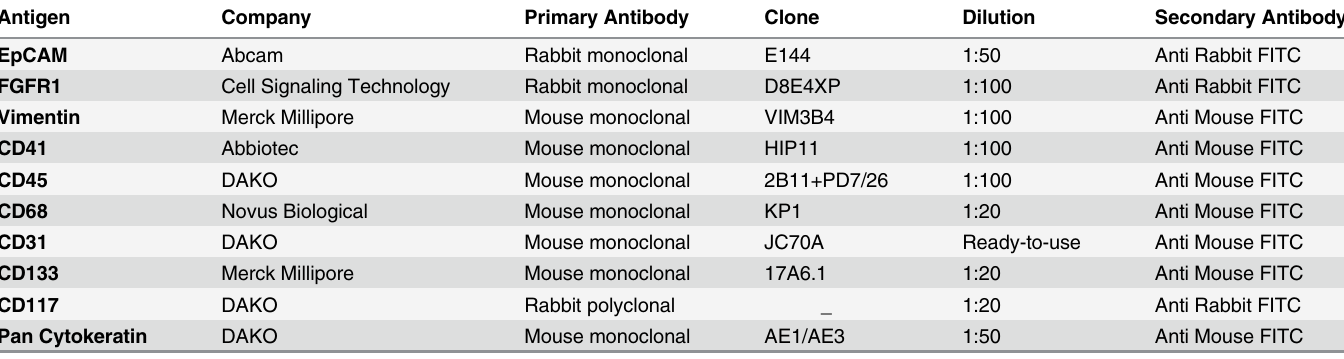
Table 1. Antibodies and their dilutions used for